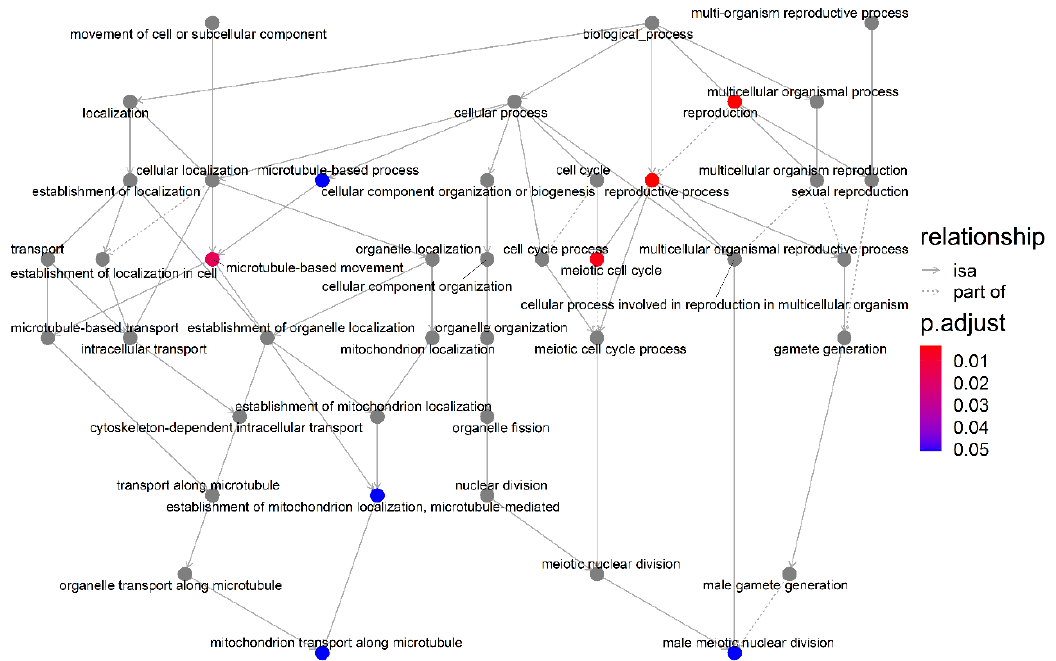
Figure 3. Association network diagram between GO terms of enrichment genes. The solid line represents the complete correlation of the two biological processes, and the dotted line represents the partial correlation. The color represents the size of the adjusted p value.